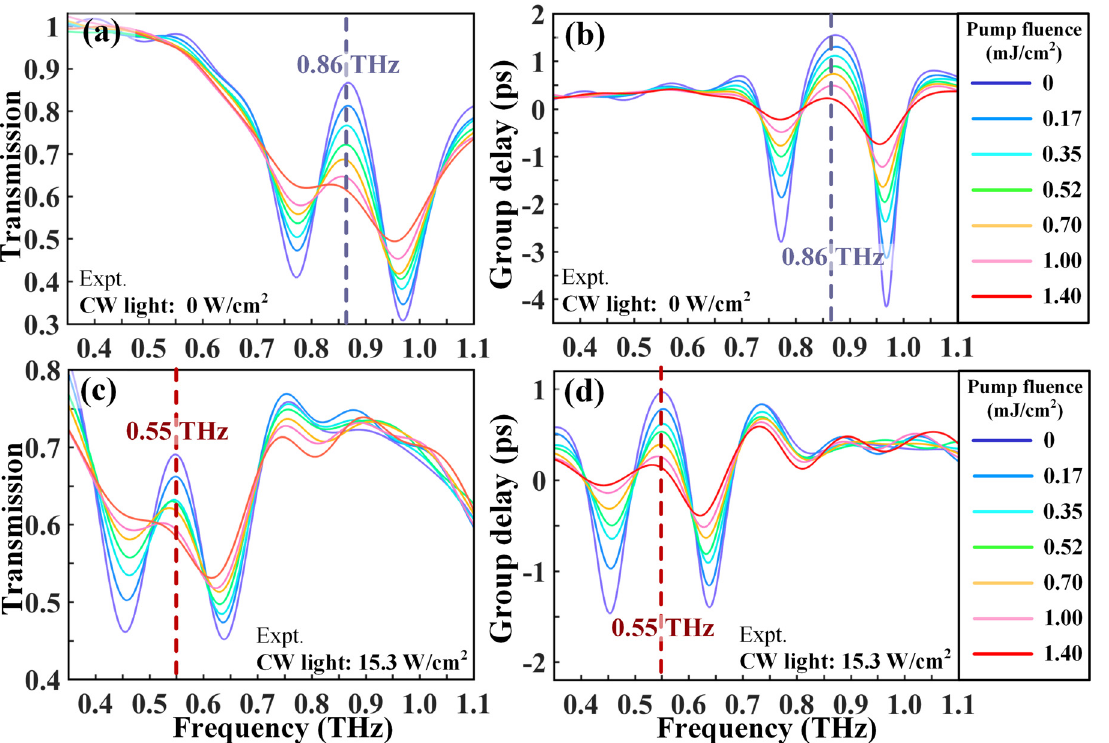
Figure 3: Controlling THz transmission/group delay spectrum via the femtosecond pulses impinging on the hybrid metadevice before and after the metaatom